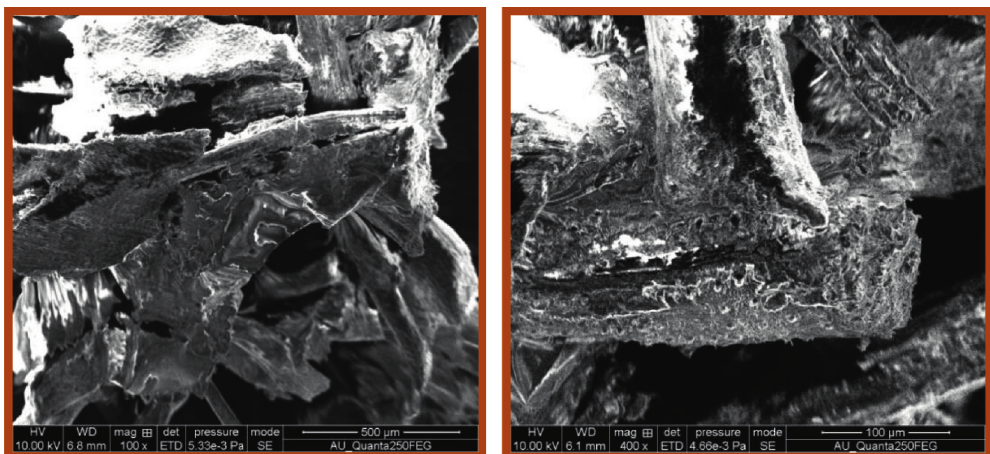
Figure 7: SEM images after the surface roughness test.